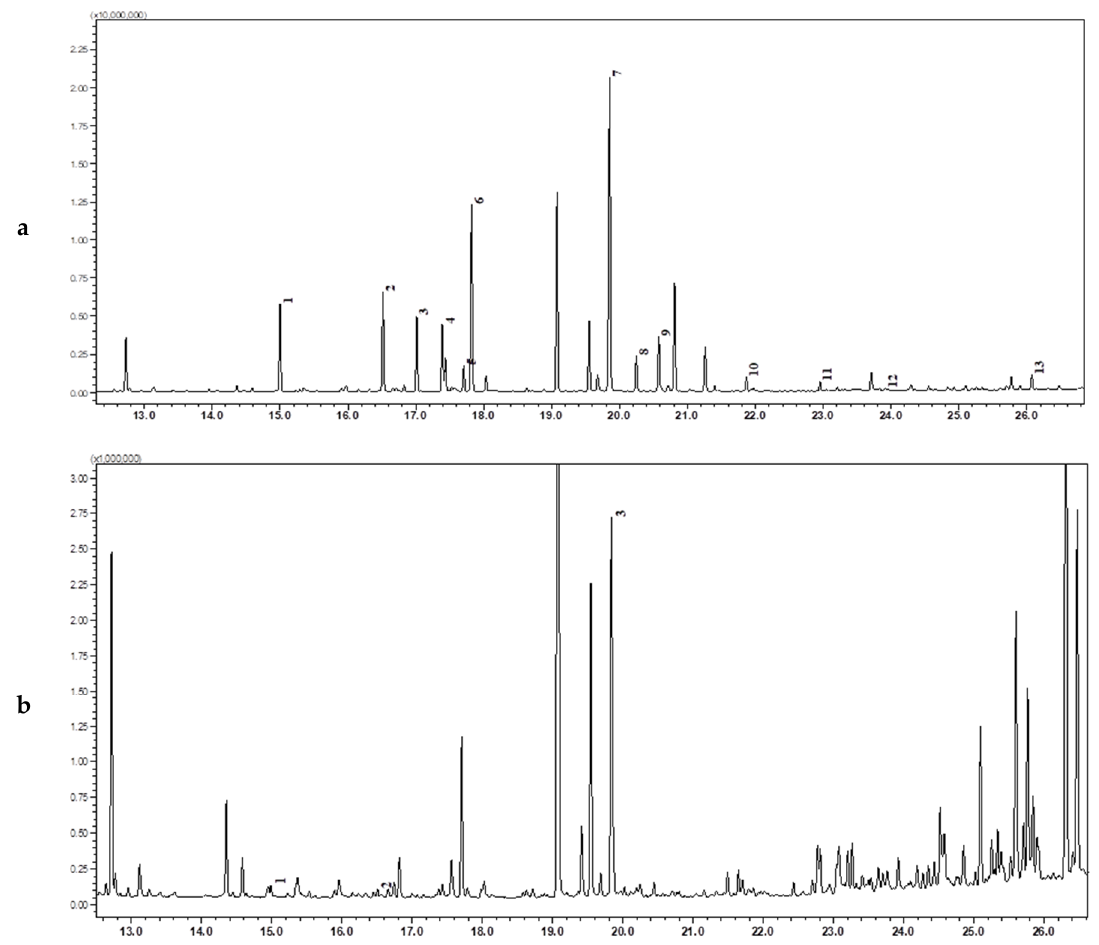
Figure 2. GC–MS chromatograms for the analysis of amino acid Crocus leaves ( a ) and Gladiolus leaves